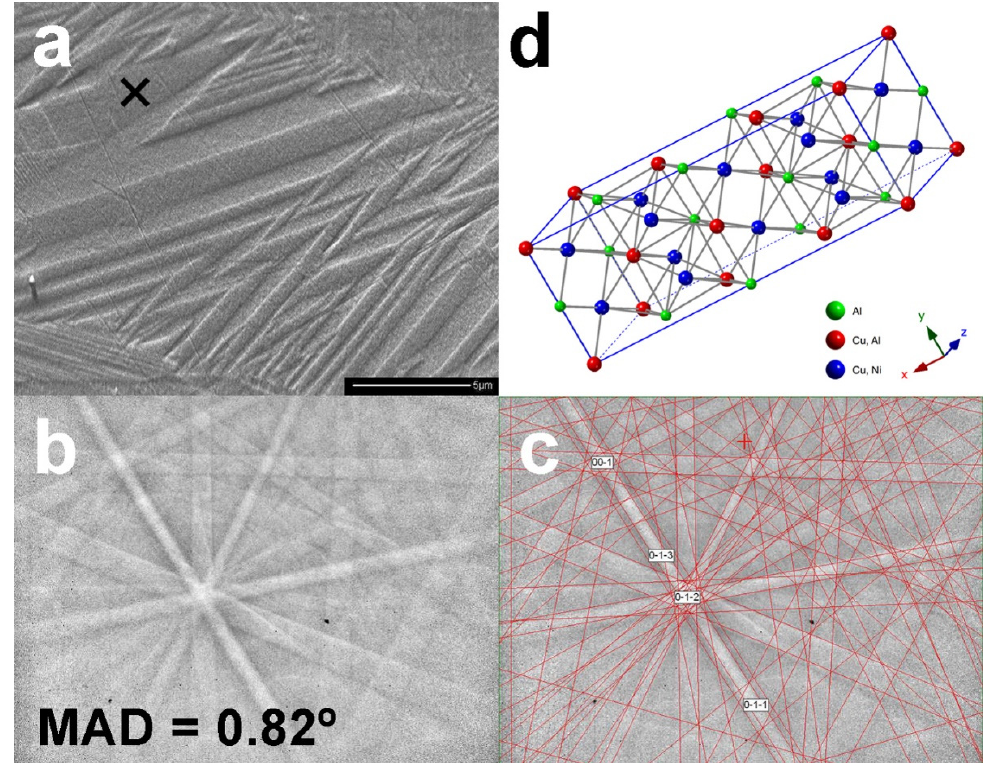
Figure 12. EBSD measurements on the LPBF–fabricated material (SM–2). ( a ) SME–BSE image of martensite variants. ( b ) EBSD pattern corresponding to the point marked with an x in ( a ). ( c ) Indexed EBSD pattern indicating the main Kikuchi lines. ( d ) Monoclinic 𝛽 (cid:2871)(cid:4593) martensite orientation of the pattern indexed in ( c ). The MAD parameter indicates the quality of the fitting.